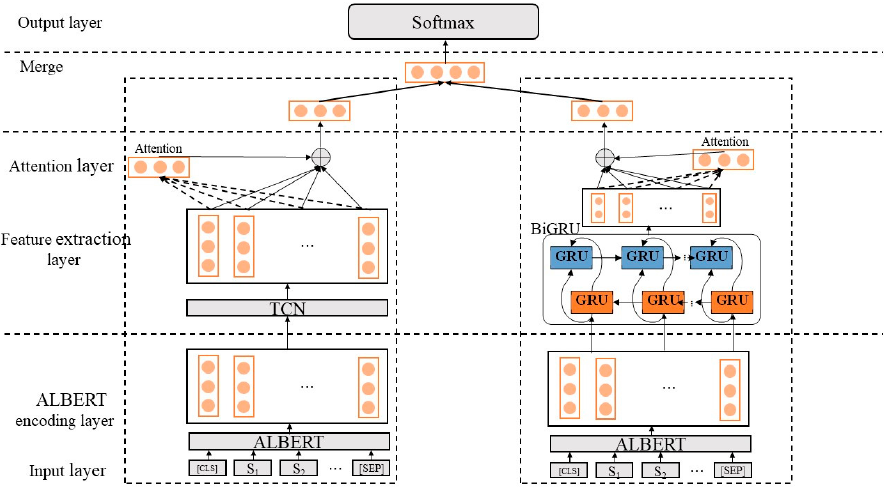
Figure 3. TCN-BiGRU-DATT model structure.